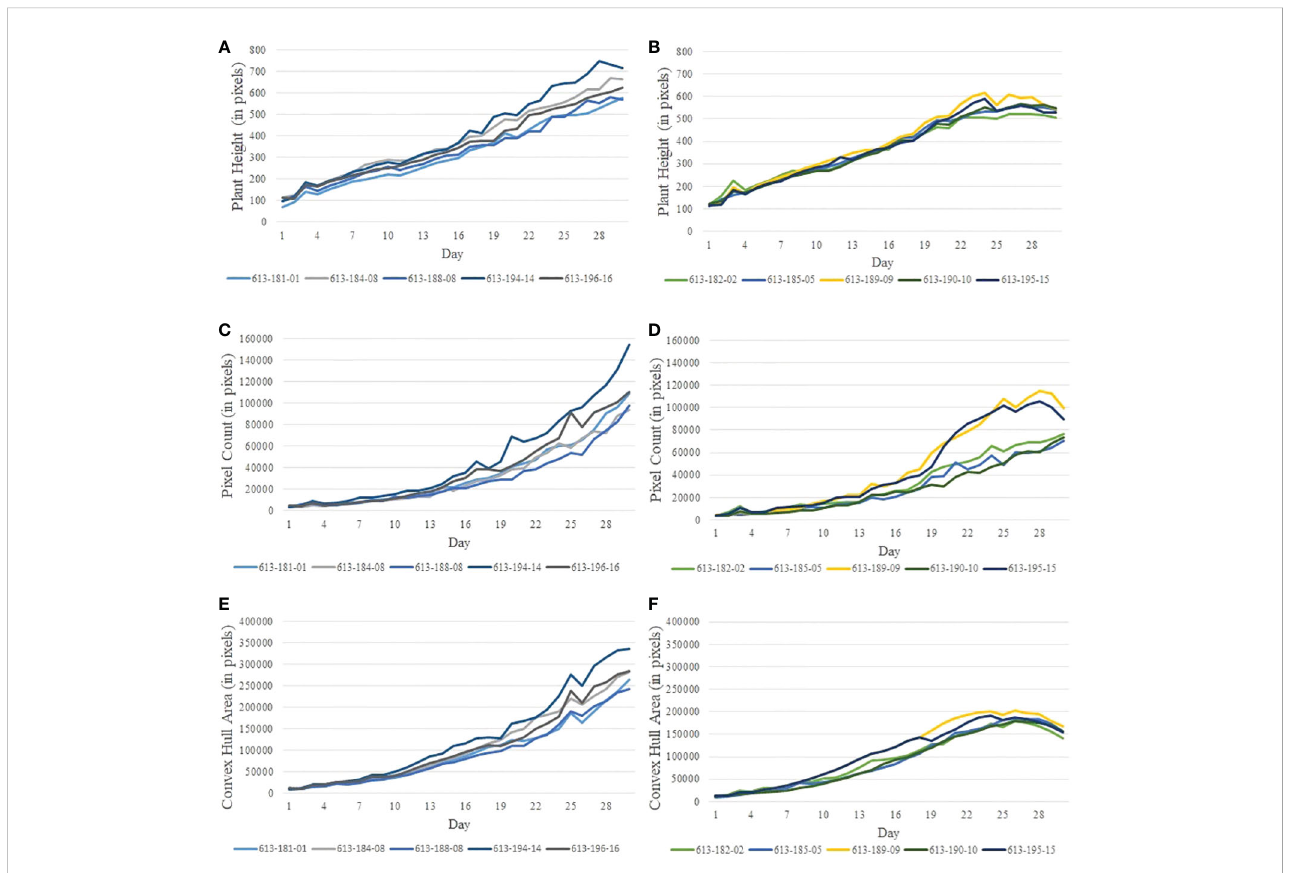
FIGURE 3 Illustration of nonlinear phenotypic time series using plants from Experiment 2: (A, B) - phenotypic time series for the height of plants under the controlled environment and subjected to drought stress, respectively; (C, D) - phenotypic time series for plant biomass (measured by pixel count) under the controlled environment and subjected to drought stress, respectively; and (E, F) - phenotypic time series for plant size (measured by the area of convex hull) under the controlled environment and subjected to drought stress, respectively.